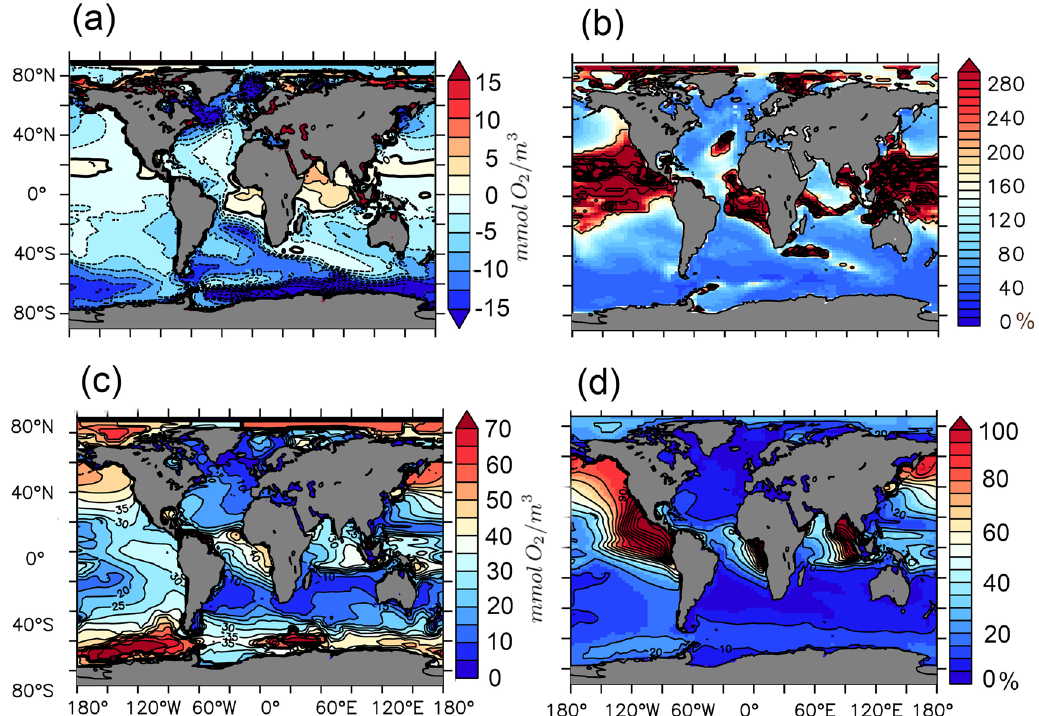
Figure 2. ( a ) Ensemble mean of simulated changes that accumulated from the preindustrial period to year 2100. Regions where the local minimum of oxygen concentrations is projected to decrease (increase) are denoted in blue (red). ( b ) Measure of the (parametric uncertainty-induced) spread of the projected changes (calculated as the standard deviation of the ensemble) normalized by the respective local amplitude of the ensemble mean changes. The unit of this noise-to-signal metric is %. Blue colours denote combinations of rather high anticipated changes with rather low parameter uncertainty. Red colours denote areas where anticipated changes are rather low and/or where the uncertainty as expressed by the ensemble spread is high. ( c ) Spread (calculated as standard deviation) among ensemble members reproducing the contemporary local minimum of oxygen concentrations in the water column. Red values denote regions where ensemble members differ − 3 widely. The unit is mmol O 2 m . ( d ) Same as ( c ) but normalized by the contemporary ensemble mean of